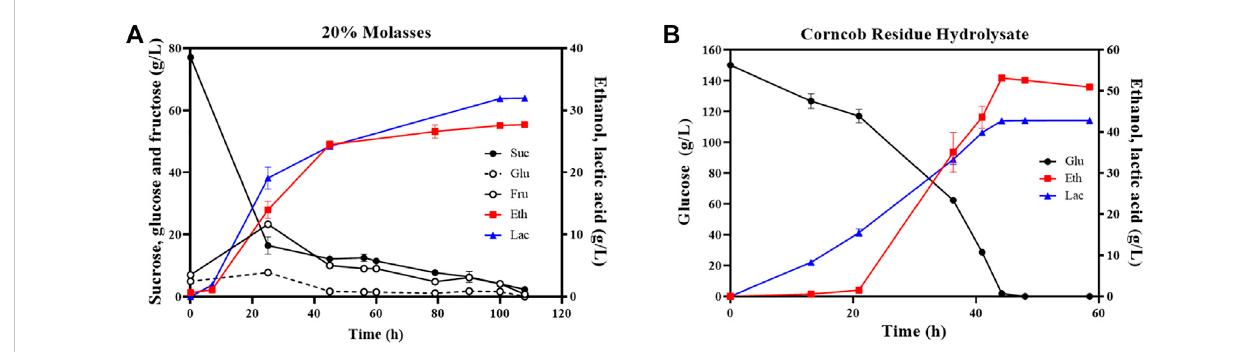
FIGURE 3 BatchfermentationofZML-pdc-ldhin20%beetmolasses (A) andcorncobresiduehydrolysate (B) .Glu,Eth,andLacrepresentglucose,ethanol,and lactate, respectively. Three replicates were performed for the